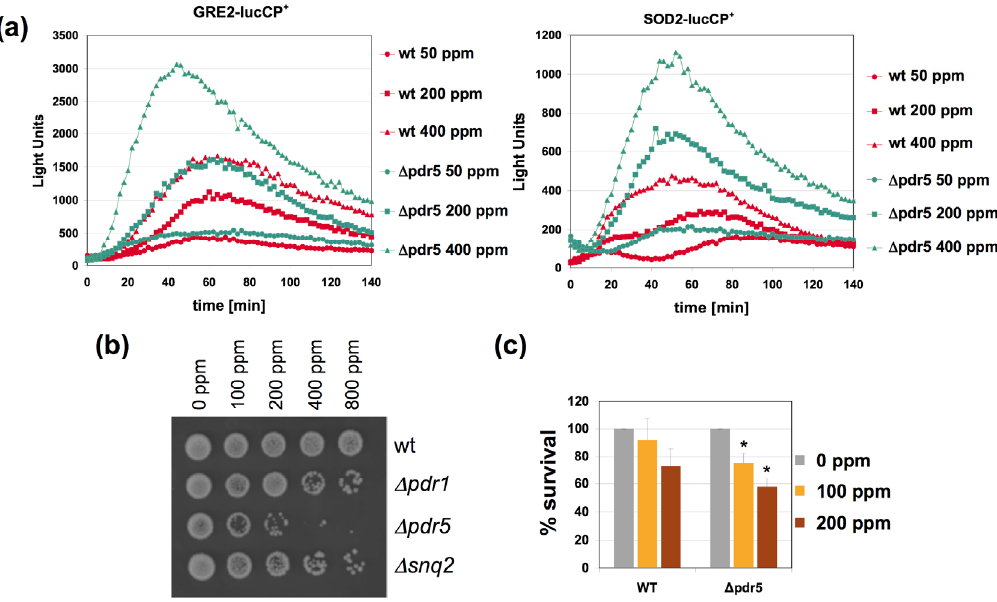
Figure 4. The yeast Pdr5 multidrug transporter is important for the citrinin dose response and sensitivity. ( a ) Fusions of the stress inducible GRE2 ( left panel ) or SOD2 ( right panel ) promoters with destabilized luciferase were used as a real time reporter for gene expression. The reporter activity was measured in yeast wild type and pdr5 mutants upon addition of the indicated concentrations of citrinin. Data shown are mean values from three independent biological samples. SD < 15%; ( b ) pdr5 mutants show increased sensitivity to citrinin. The indicated citrinin doses were applied to yeast wild type, pdr1 , pdr5 and snq2 mutants for three hours in YPD culture medium. Surviving cells were then assayed on a fresh YPD plate; ( c ) Yeast wild type and pdr5 mutant cells were incubated for one hour with the indicated amounts of citrinin in KP buffer. The amount of living cells was then quantified by staining with FDA. Data are mean values from three independent biological replicas. Error bars are SD. The asterisks refer to p < 0.05 different from wt in the same condition according to the Student’s t -test. The value for mock treated cells was arbitrarily set to 100 for both yeast